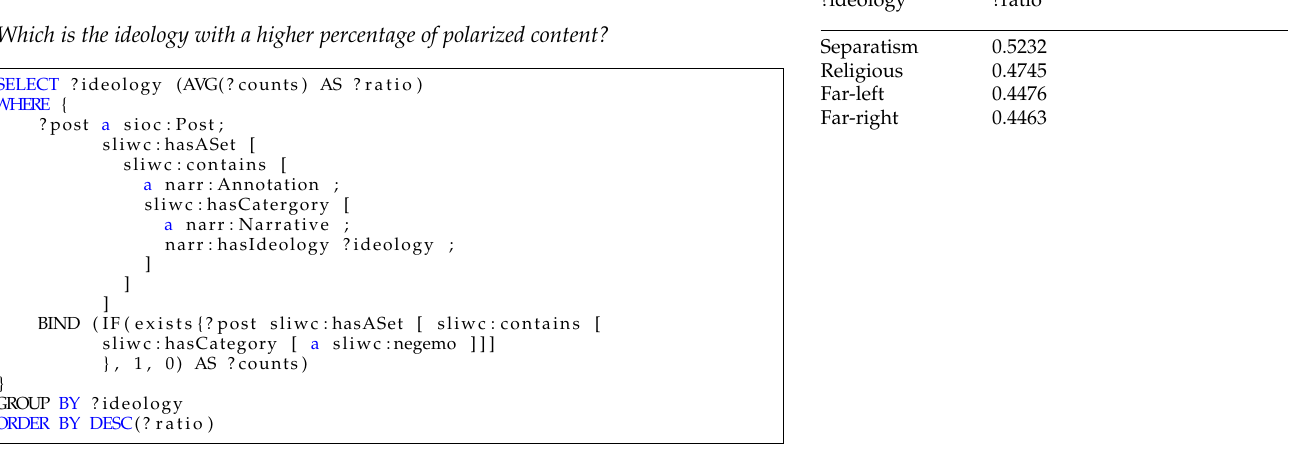
Table 6. Competency question—Q3.